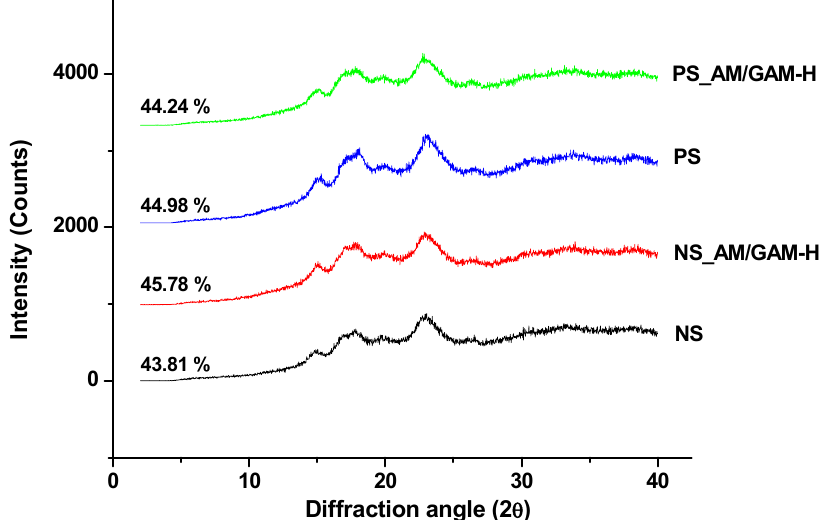
Figure 2. X-ray diffraction (XRD) pattern of starch samples: native starch (NS), pretreated starch (PS) and starch hydrolyzed with the mixture of α -amylase and glucoamylase with the highest dose (NS_AM/GAM-H and PS_AM/GAM-H). Relative crystallinity percentage is shown on the left side of each curve.